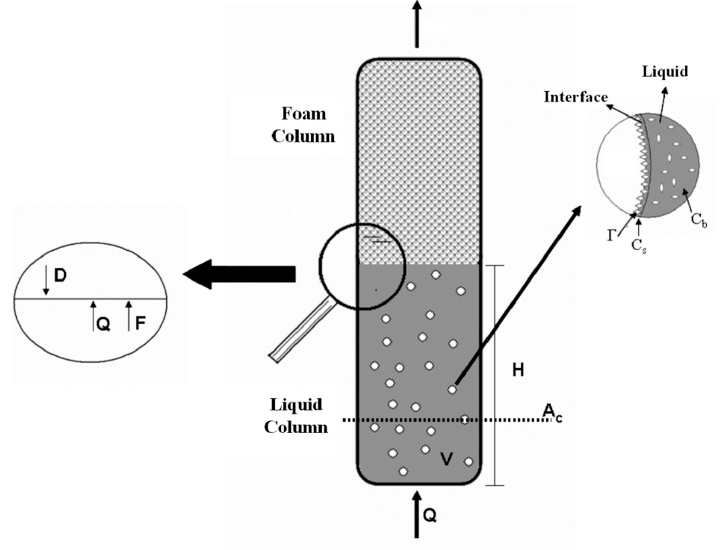
Figure 1. Schematic diagram of the bubble and foam column and surfactant adsorption on the surface of the gas